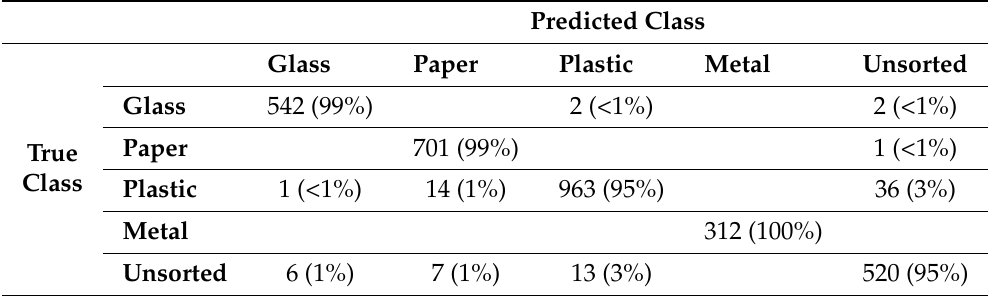
Table 6. Test confusion matrix obtained for hybrid classification with integration at